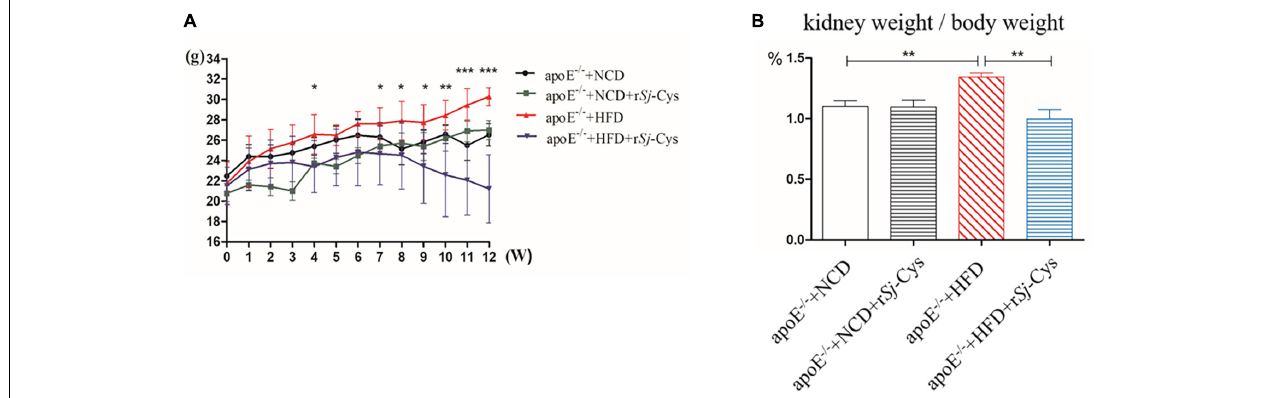
FIGURE 2 | r Sj -Cys treatment reduced HFD-induced body weight gain in mice. (A) The changes in body weight throughout the experimental period. (B) The changes in the percentage of kidney weight/body weight ratio. The results are shown as the mean ± SEM for each group ( n = 6 per group). * P < 0.05, ** P < 0.01, *** P <